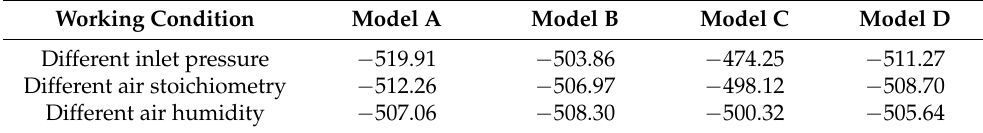
Table 5. Average AIC values of the model fitting results under different working conditions. Working